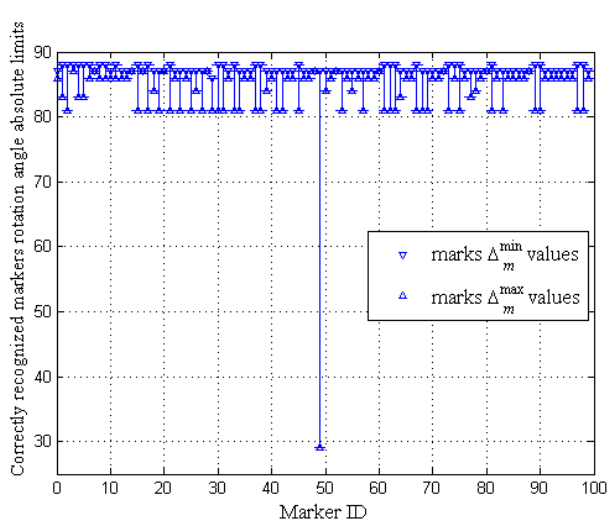
Fig. 7. Limiting angles along which rotated in all considered directions and virtual environment scenes markers are still recognized.